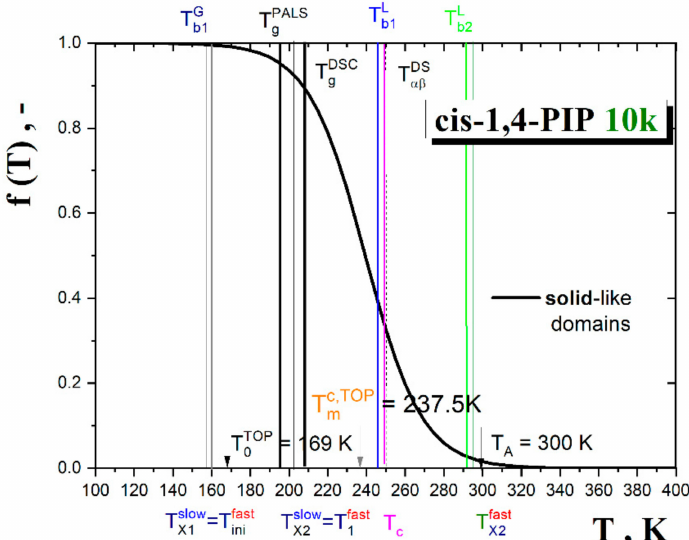
Figure 14. Probability function of solid-like domains, f ( T ), or the liquid-like regions, 1 − f ( T ), obtained from Equation (11) fitting the segmental α relaxation time by Equation (11) with the charac- teristic PALS and ESR (from spectral simulations) temperatures together with the characteristic TOP temperatures as well as with the glass-to-liquid temperature T gDSC and the αβ merging temperature T αβ DS